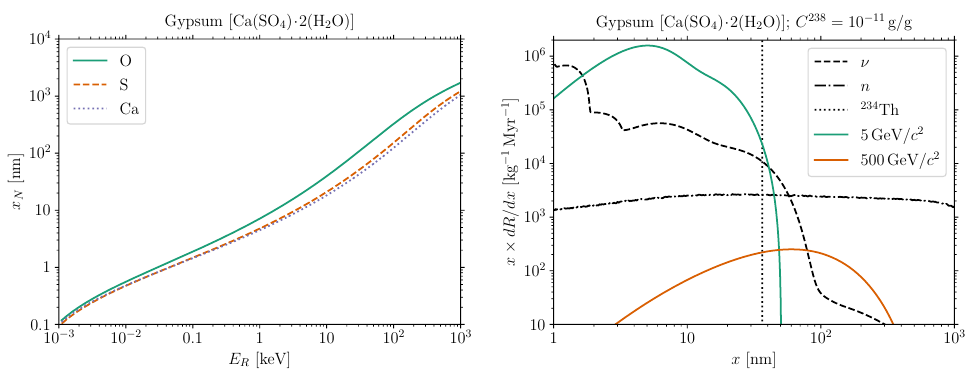
Figure 1. ( Left ): Range x N of different ions with initial energy E R in gypsum [Ca(SO 4 ) ( Right ): Differential rate of tracks per track length and unit target mass in gypsum from a 5GeV/c 2 and a 500GeV/c 2 WIMP compared to background spectra induced by neutrinos ( ν ), radiogenic 234 Th + α recoils ( 234 Th ); see the discussion in Section 3. For the nor- neutrons ( n ), and 238 U → malization of the WIMP DM spectra, we set the spin-independent WIMP-nucleon cross sections to σ SI p = 10 − 43 cm 2 for the 5GeV/c 2 case and σ SI p = 10 − 46 cm 2 for the 500GeV/c 2 case, compatible with current upper bounds